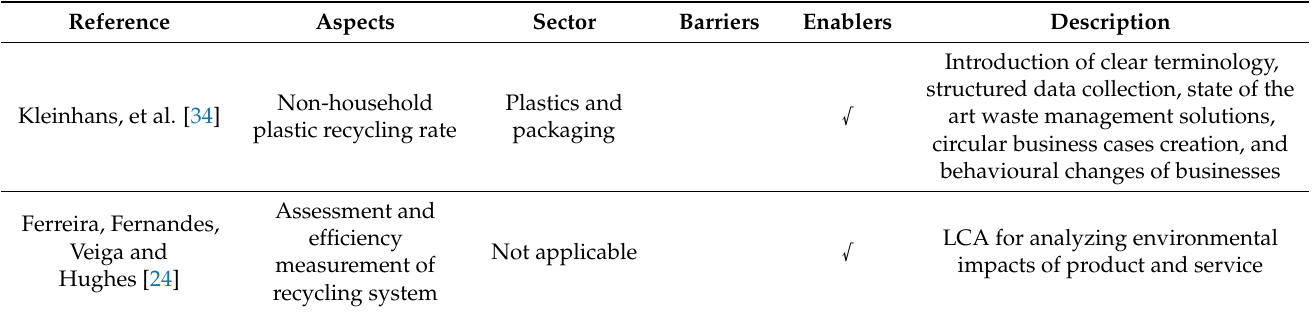
Table 1. Summary of barriers and enablers of recycling specific CBM.